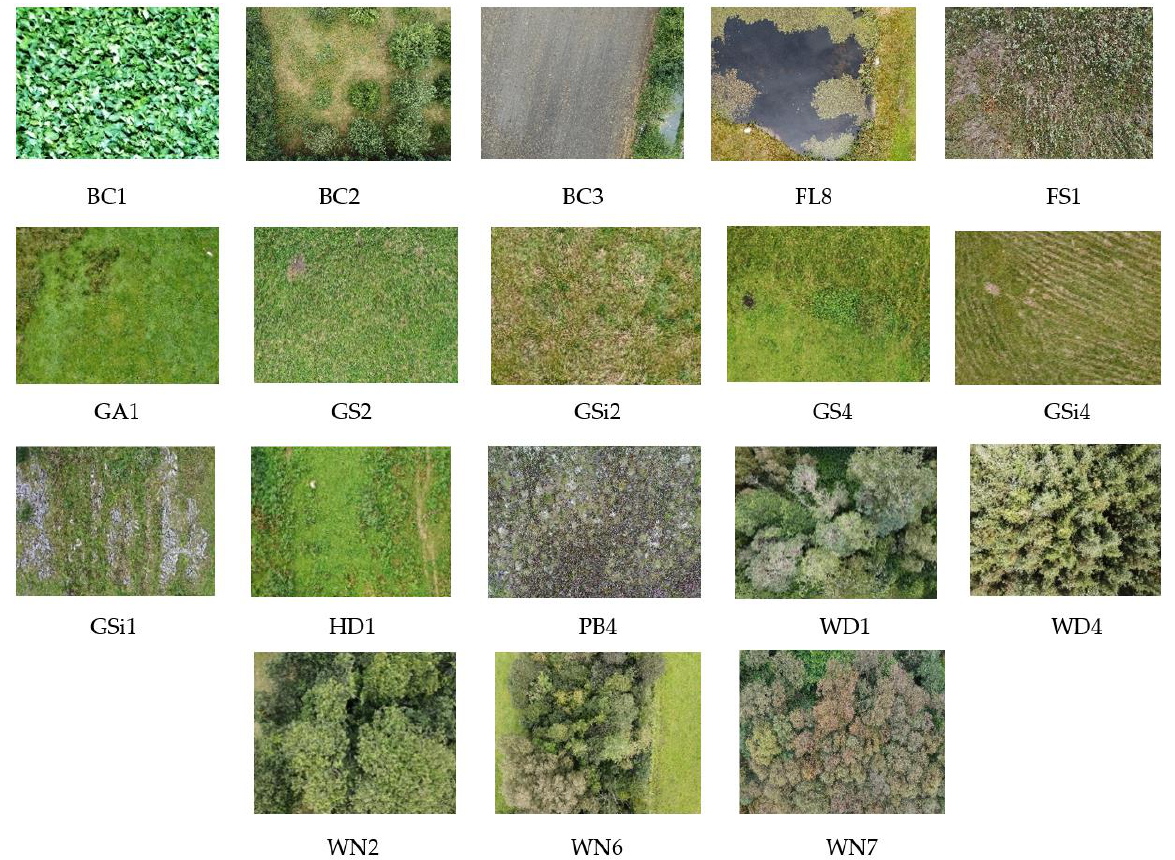
Figure 2. Sample images of 18 different habitats under study.